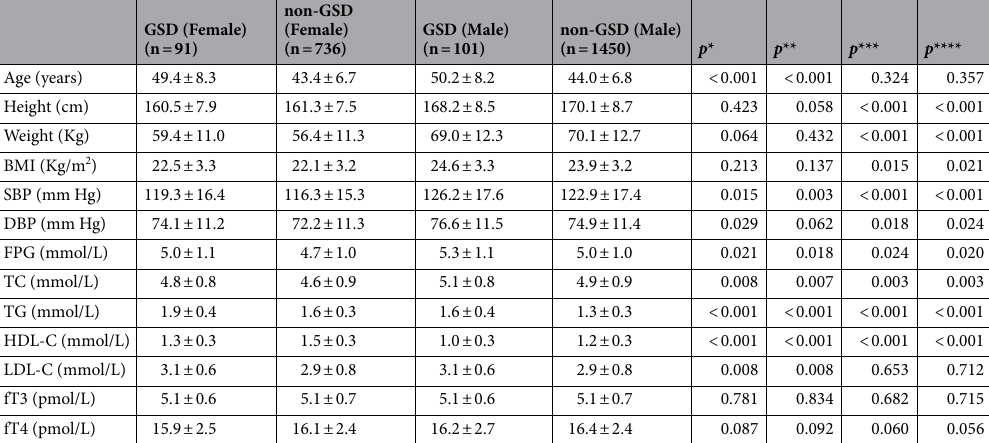
Table 1. Participants’demographic and clinical characteristics in GSD and non-GSD group based on sex. Data were presented as mean ± SD. Groups were compared using t-test. BMI Body mass index, SBP